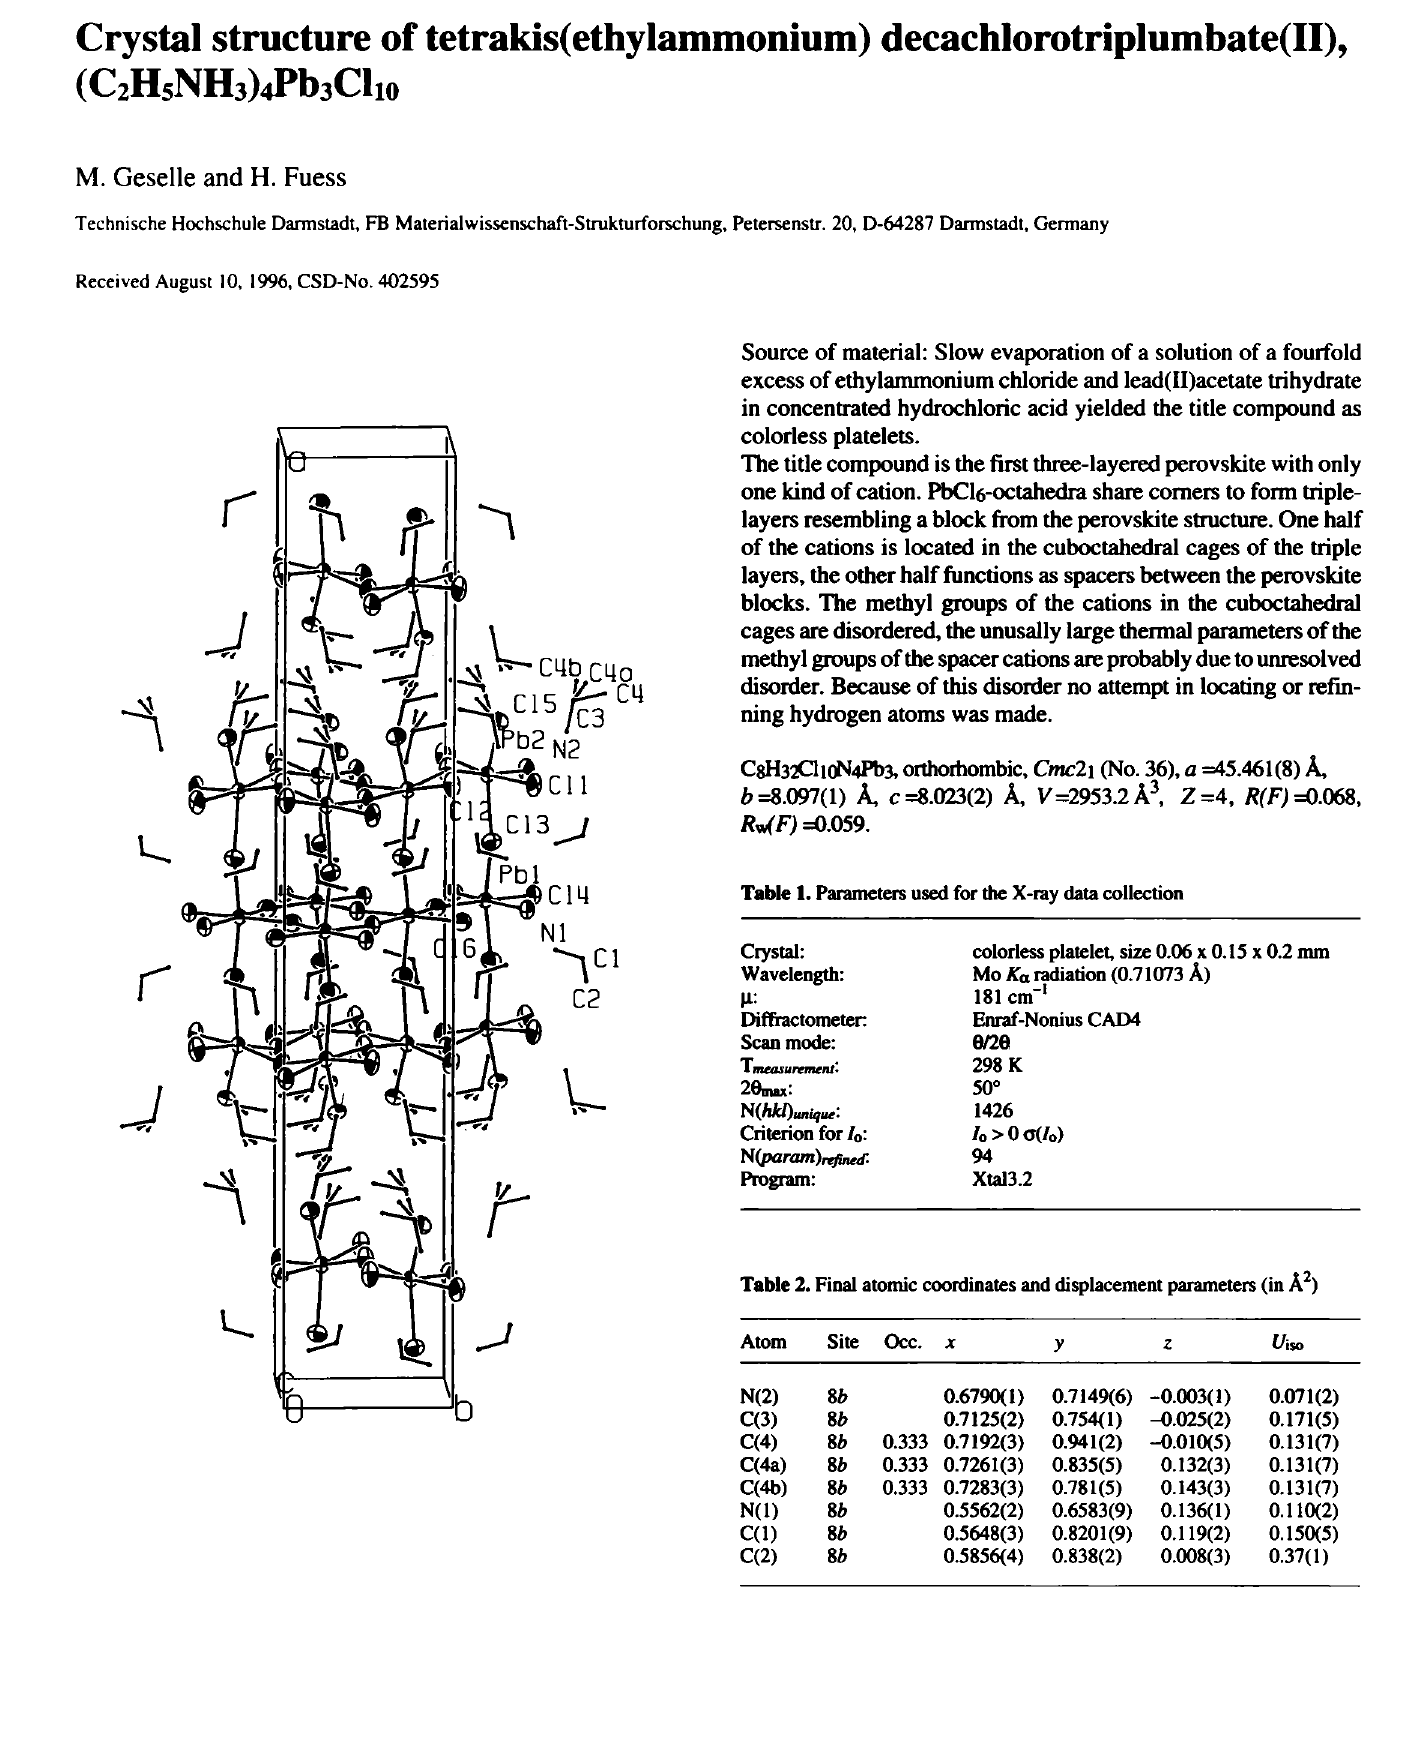
Table 2. Final atomic coordinates and displacement parameters (in Â 2